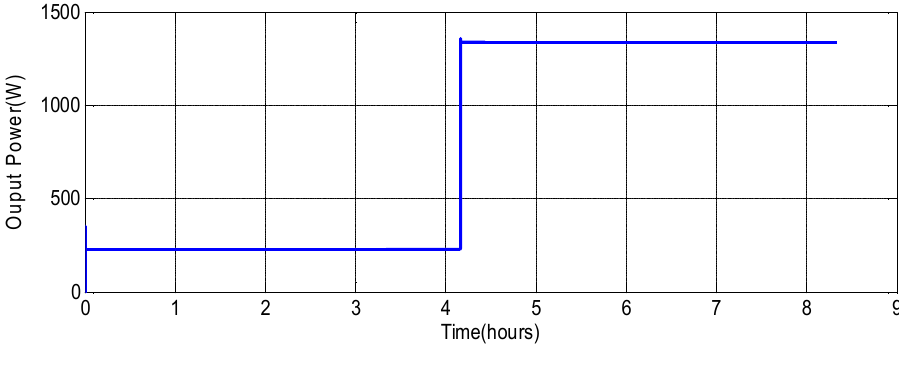
Figure 15. Output voltage vs. time to variable duty cycle. Energies 2018 , 11 , x FOR PEER REVIEW